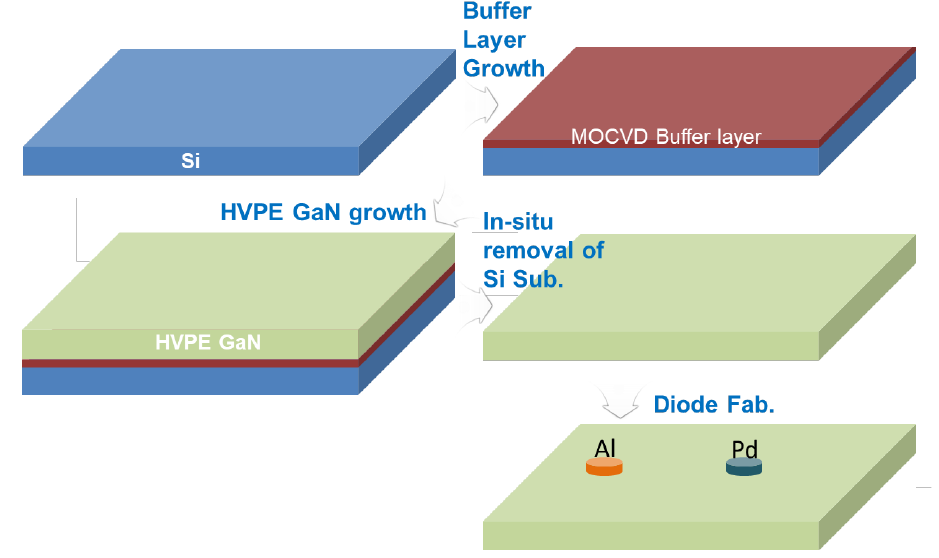
Figure 1. The fabrication procedure of the Pd/Si-based FS-GaN Schottky diode used in this study.